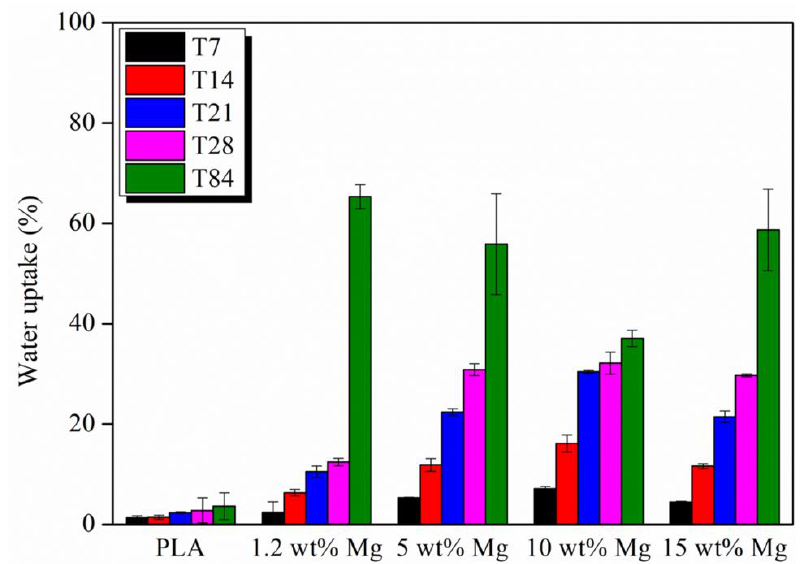
Figure 10. Percentage of water uptake for each PLA-Mg filament after 7, 14, 21, 28, and 84 days in PBS media.